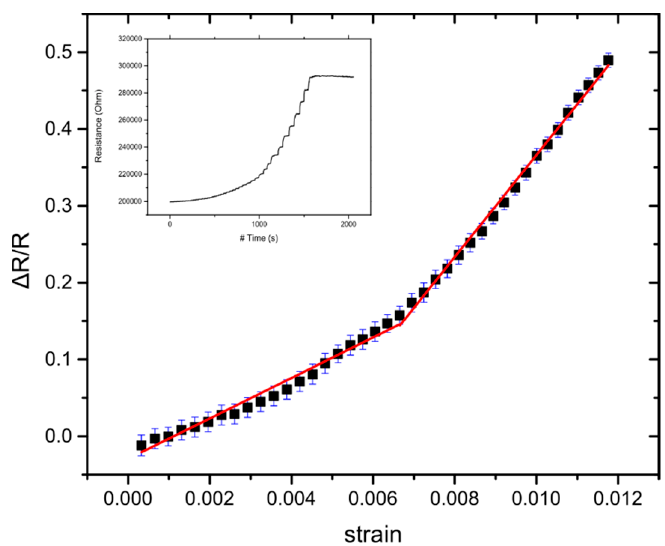
Figure 4. Measurement of resistance during gradual application of strain. Relative resistance over strain graph, where the GF is calculated by the slopes of the fitting line. Error bars represent the standard deviation of the measurements. In this particular example, the sensor has GF1~26 for lower strains and GF2~66 for higher strains.